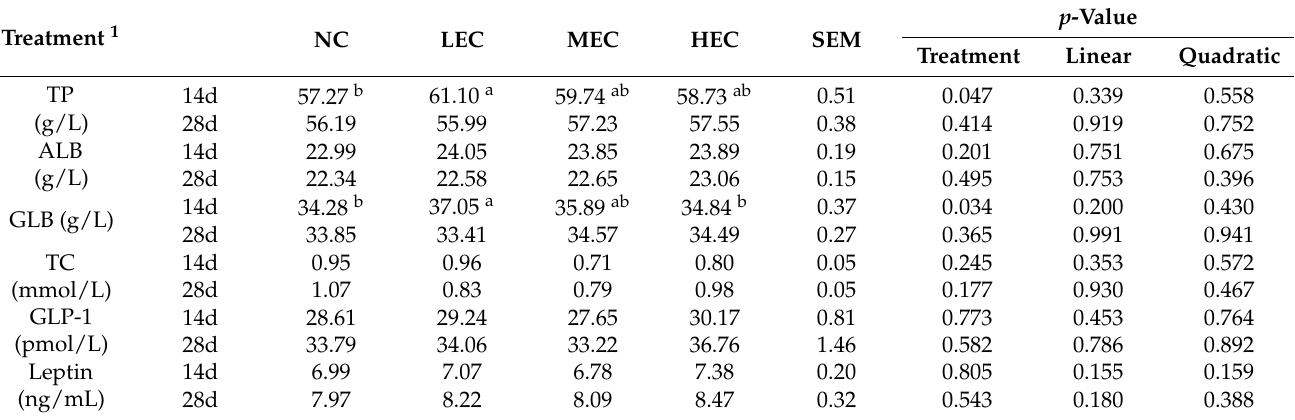
Table 6. The effects of different gelatinization degrees of extruded corn on the plasma parameters of piglets in experiment